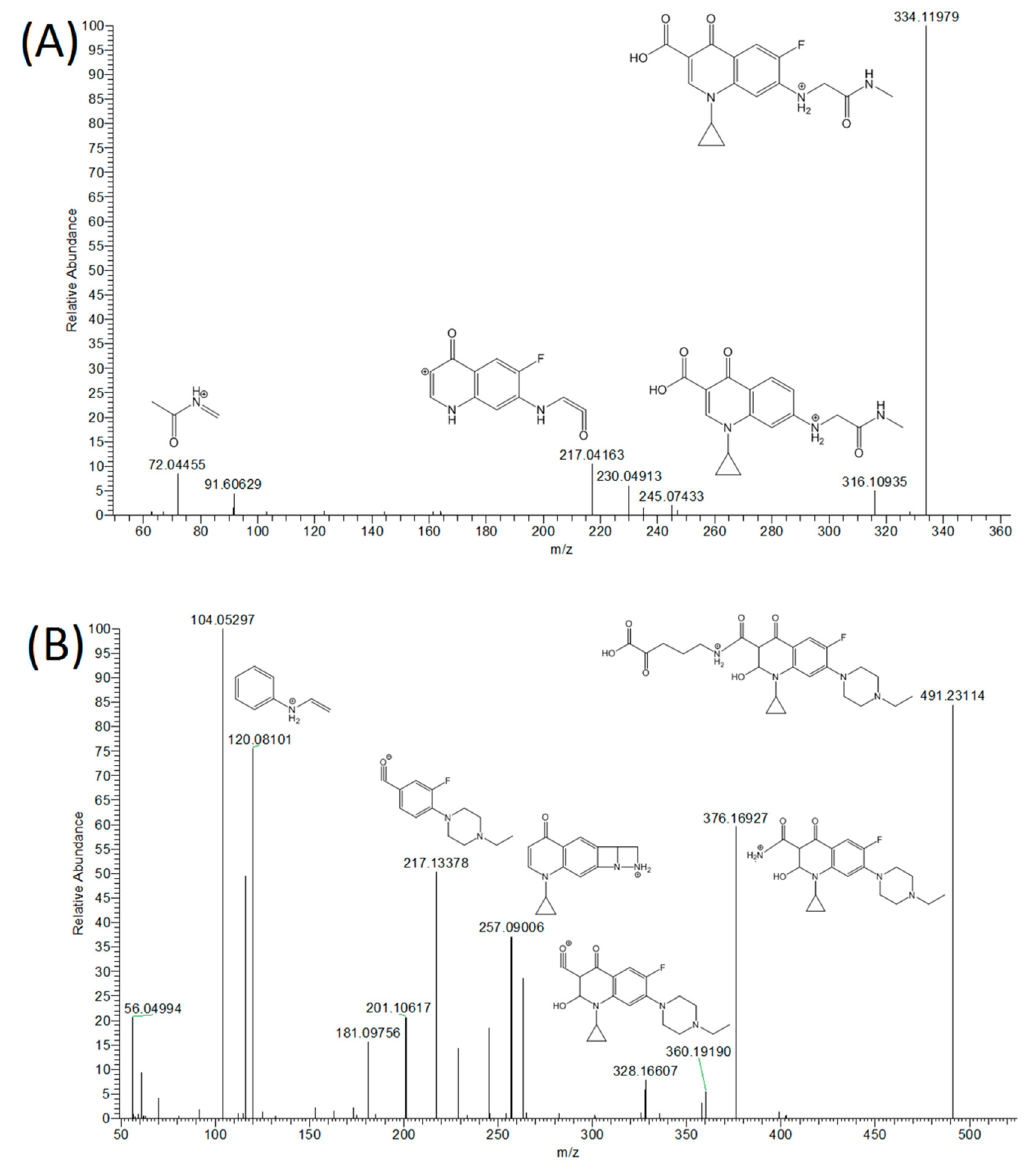
Figure 2. Mass spectral data, proposed structures and MS2 spectrum for two new enrofloxacin metabolites. ( A ) ENRO-N-methylacetamide and ( B ) ENRO-ornithine.